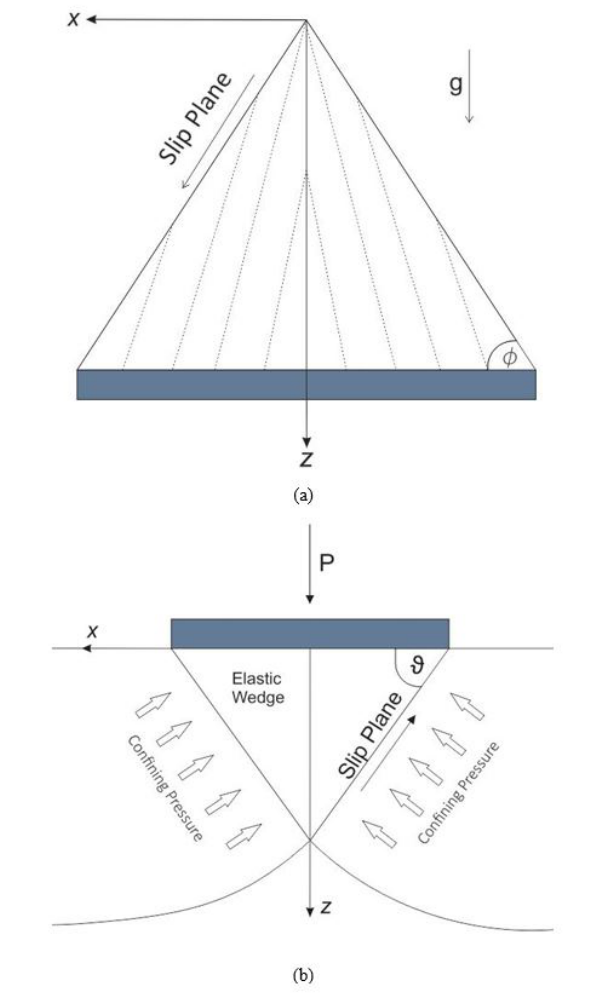
Figure 3. A qualitative comparison between the forces and geometries of ( a ) a static sandpile, and ( b ) a normally loaded shallow foundation system with underlying granular wedge. The similarities in the systems and their resulting stress phenomena (normal pressure dips and corresponding radial shear tractions fields) is used as the basis for a mechanical analogy between the two